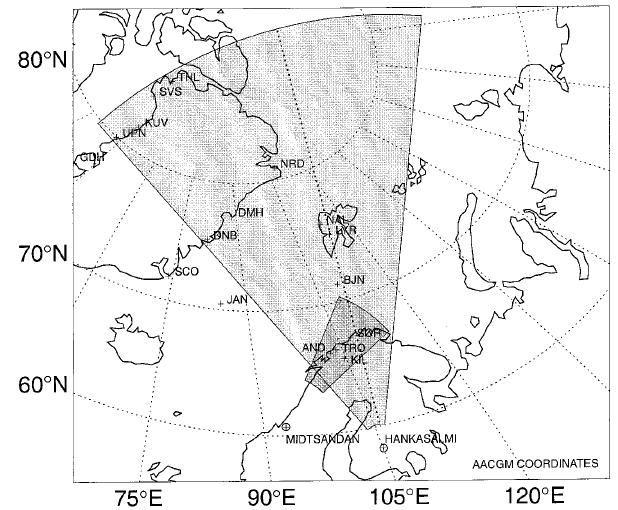
Fig. 1. Locations of the field-of-view of the CUTLASS Finland radar ( pale shading ), the STARE Norway radar field-of-view ( dark shading ) and elements of the IMAGE and Greenland magnetometer networks. Beam 9 of CUTLASS Finland which is sampled at a high rate is indicated by a dotted